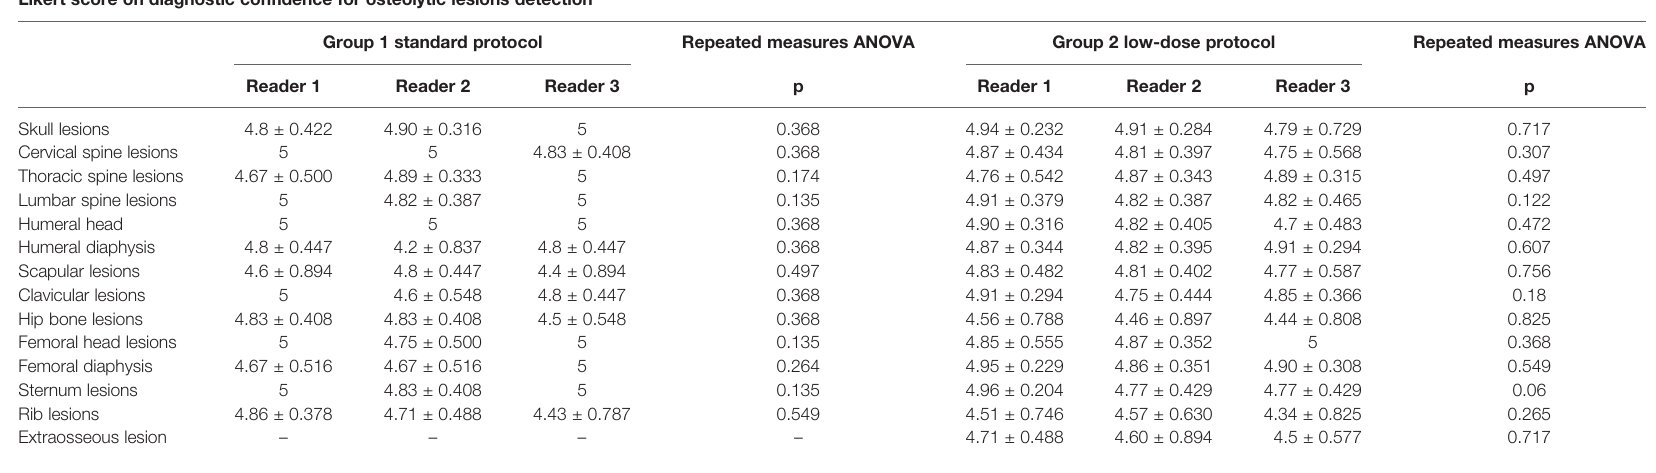
TABLE 4 | Likert scores on diagnostic con fi dence for osteolytic lesions detection. Likert score on diagnostic con fi dence for osteolytic lesions